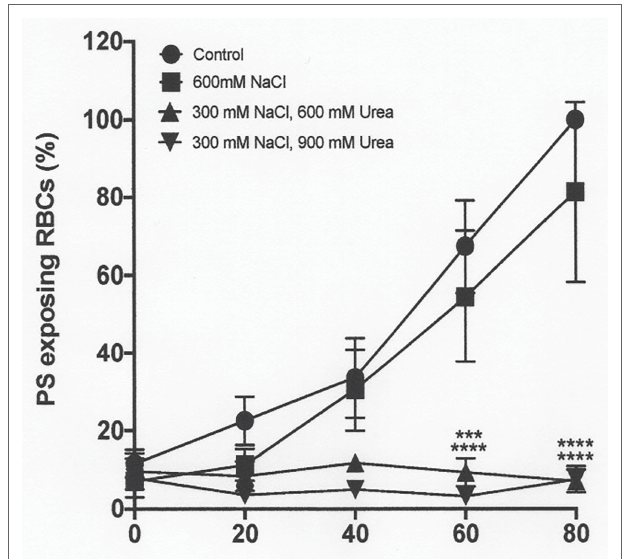
FIGURE 9 | The effect urea and hypertonic NaCl on phosphatidylserine exposure in deoxygenated red cells from patients with SCA. Red cells (1% Hct) were incubated in Eschweiler tonometers at 37 o C, pH 7.4 and an osmolality of 290 - 1200 mOsm.kg-1 (through addition of hypertonic NaCl) for up to 80 min under fully deoxygenated (0 mmHg oxygen) conditions in the absence of urea or at two different urea concentrations (600 and 900 mM). At the time intervals indicated, red cell aliquots were removed and PS exposure measured using LA-FITC, as described in the Methods. Symbols represent means ± SEM, n = 3. *** p < 0.01; and **** p < 0.0001., comparing red cells in the absence of urea at 290 mOsm.k